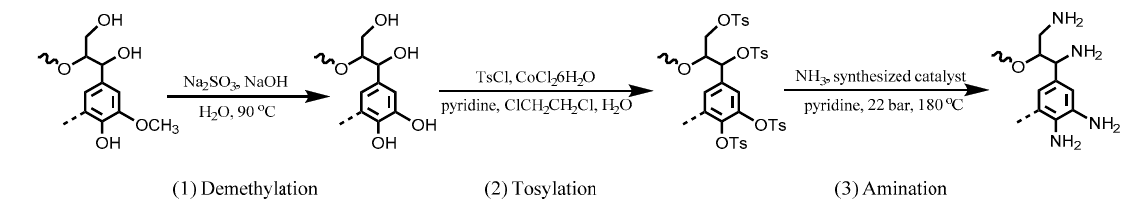
Figure 7. Direct primary amination of lignin. Adapted from [39].